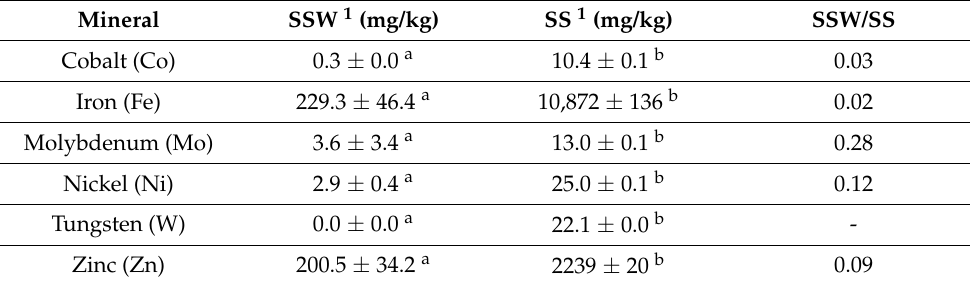
Table 7. Comparison of the mineral contents of SSW and SS.